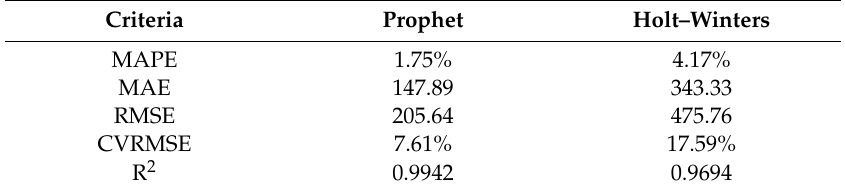
Table 1. The calculated values of different performance statistical metrics for both models. Criteria